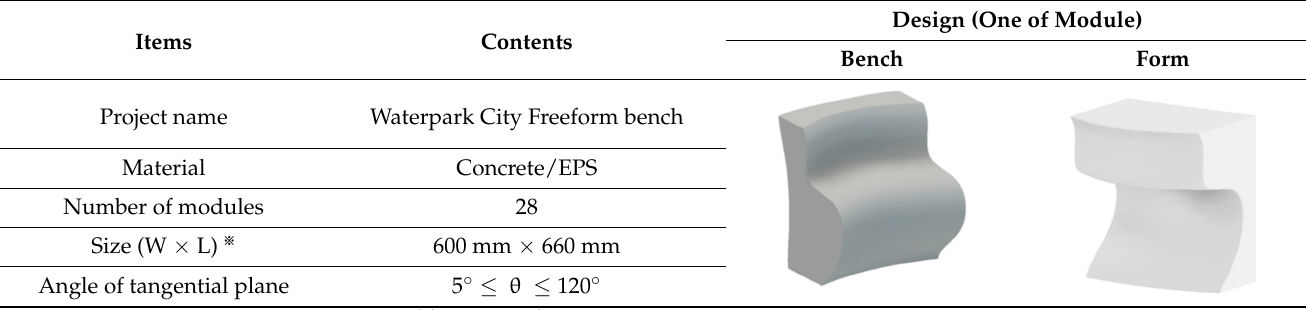
Table 2. Description of case project.